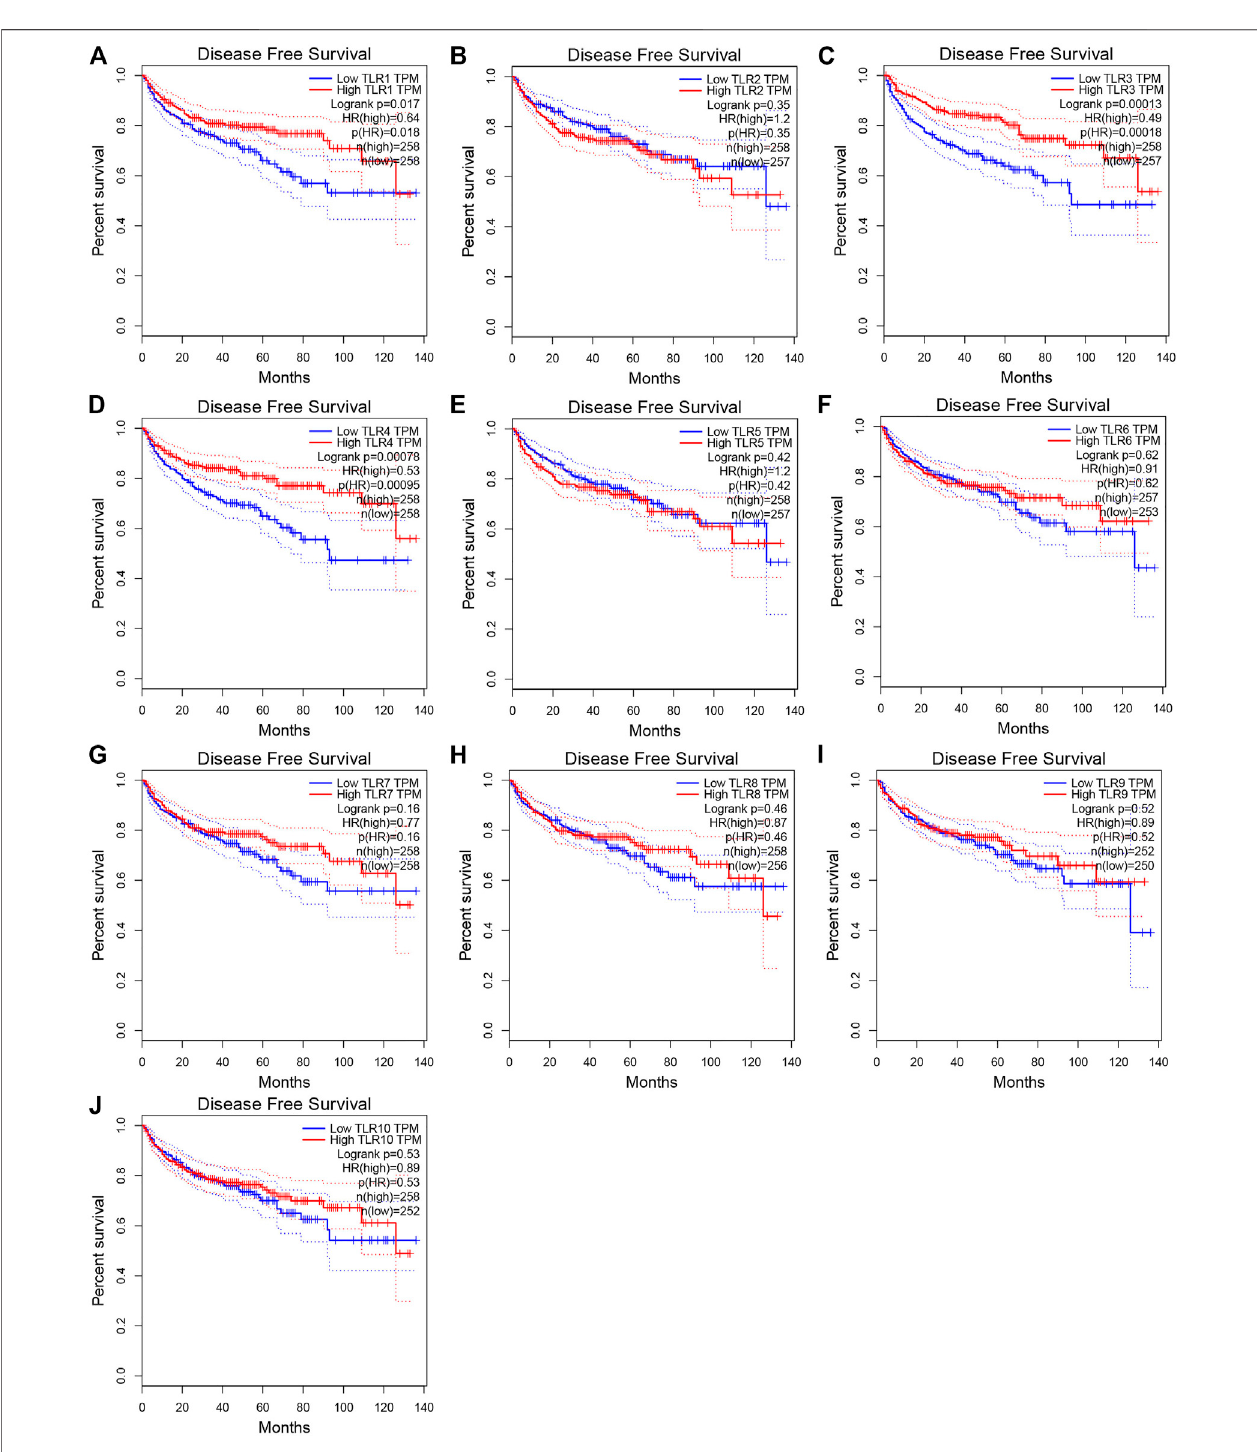
FIGURE6| EffectsofTLRsondiseasefreesurvivaltimeofpatientswithKIRC. (A) TLR1, (B) TLR2, (C) TLR3, (D) TLR4, (E) TLR5, (F) TLR6, (G) TLR7, (H) TLR8, (I) TLR9, (J) TLR10.